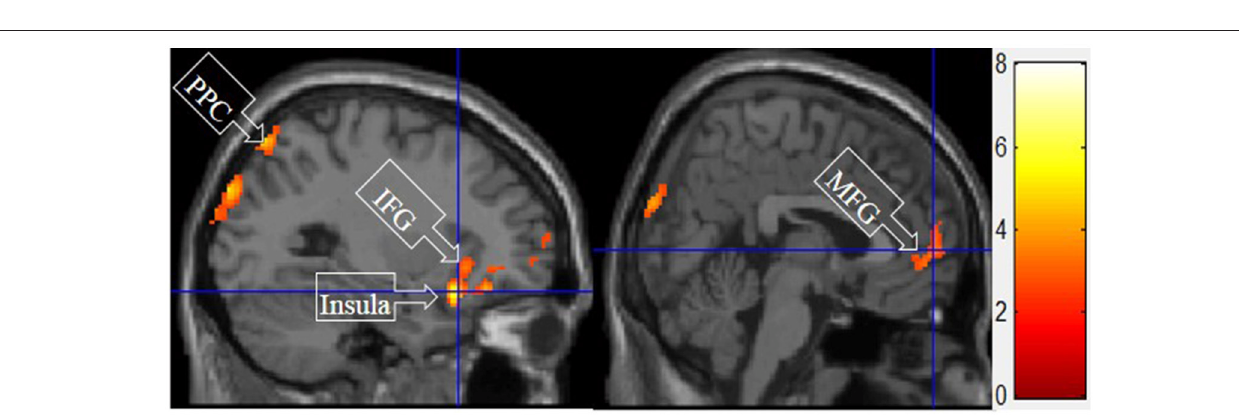
FIGURE 7 | Symbolic motivation > experiential and functional motivations. The color bar reflects t -values that resulted from the contrast. The PPC, IFC, insula, and MFG showed significantly higher activation while processing products with symbolic motivation as compared to both experiential and functional